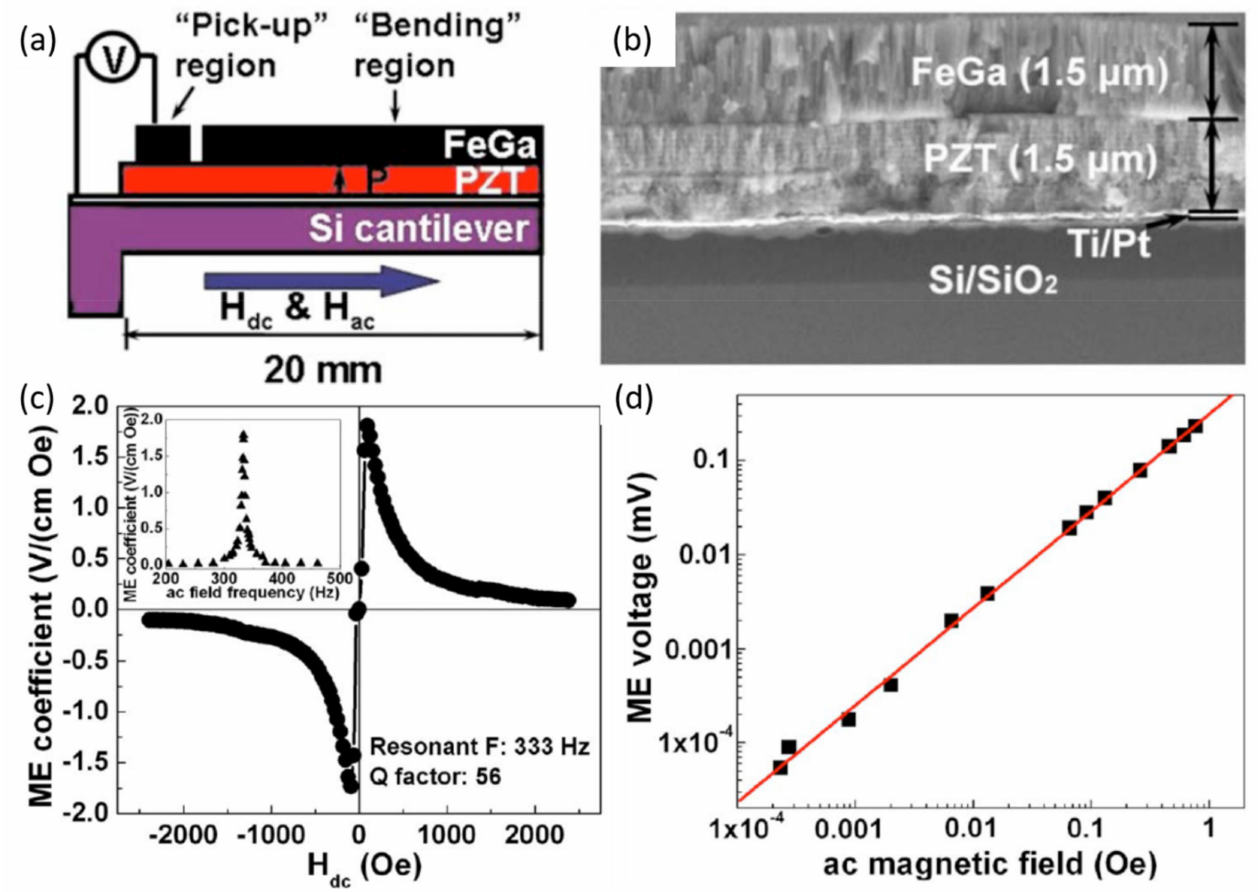
Figure 2. ( a ) Schematic representation of the fabricated FeGa/PZT ME sensor. ( b ) SEM image of FeGa/PZT ME sensor. ( c ) H dc dependent of α E of a FeGa/PZT sensor at its resonant frequency. Inset: Frequency-dependent α E . ( d ) α E as a function of magnitude of an AC field at 333 Hz under a DC magnetic field of 90 Oe. Reprinted with permission from ref. [24]. Copyright 2009 AIP